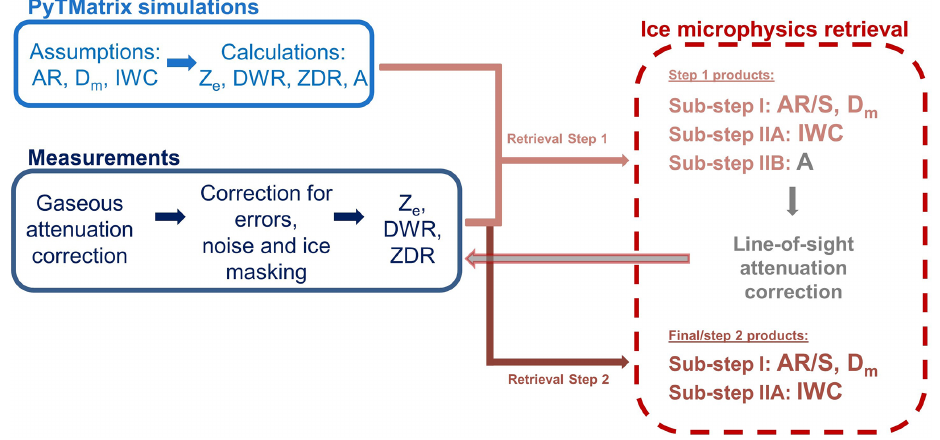
Figure 10. Ice microphysics flowchart. The dark blue refers to radar observations. The light blue is used for scattering simulations, and the red dotted rounded rectangle gives information about the ice microphysics retrieval scheme. In gray, the total attenuation correction method is described.